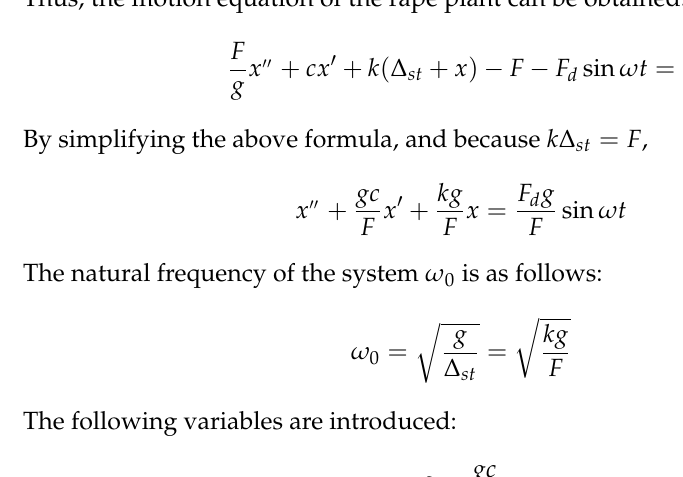
Figure 3. Simplified stress analysis model.